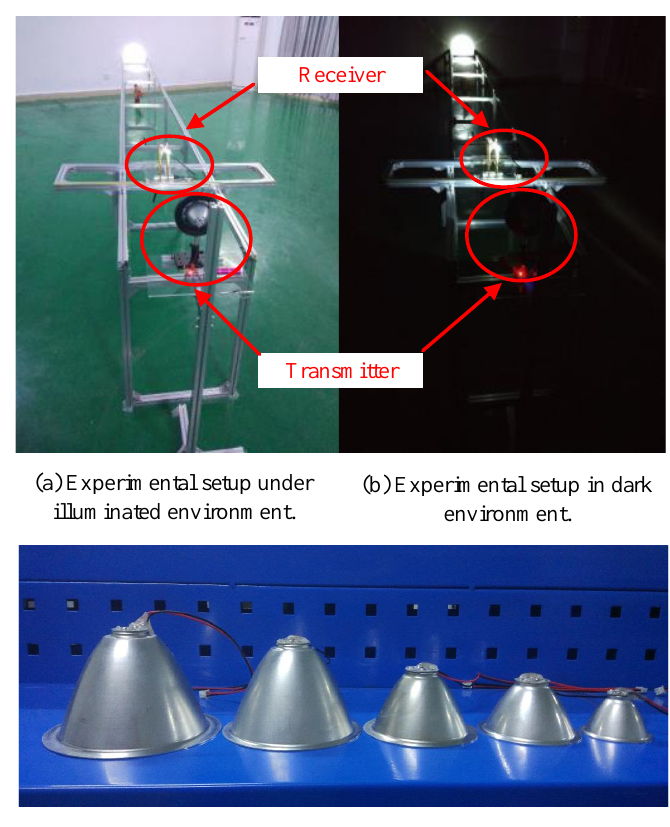
Figure 5. Experimental